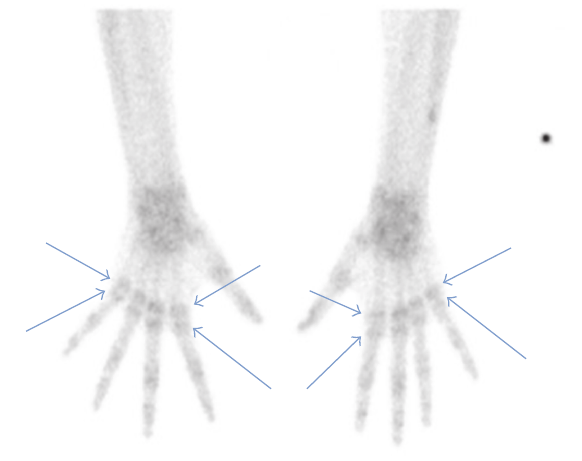
Figure 3: Triple-phase radioisotope bone scan (delayed phase) showing increased periarticular tracer uptake (arrows) with sparing of the joint space, more evident in metacarpophalangeal joints of both hands, and also diffusely increased tracer uptake over both